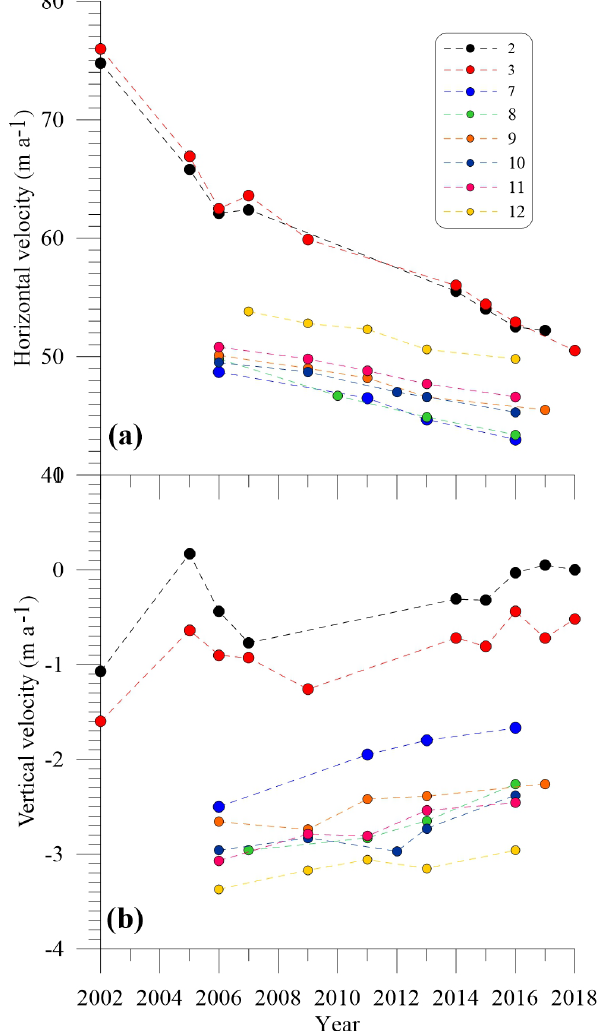
Figure 11. Horizontal (a) and vertical (b) velocities observed at the different stakes at 2550ma.s.l. (stakes 2 and 3) and 2700ma.s.l. (stakes 7, 8, 9, 10, 11 and